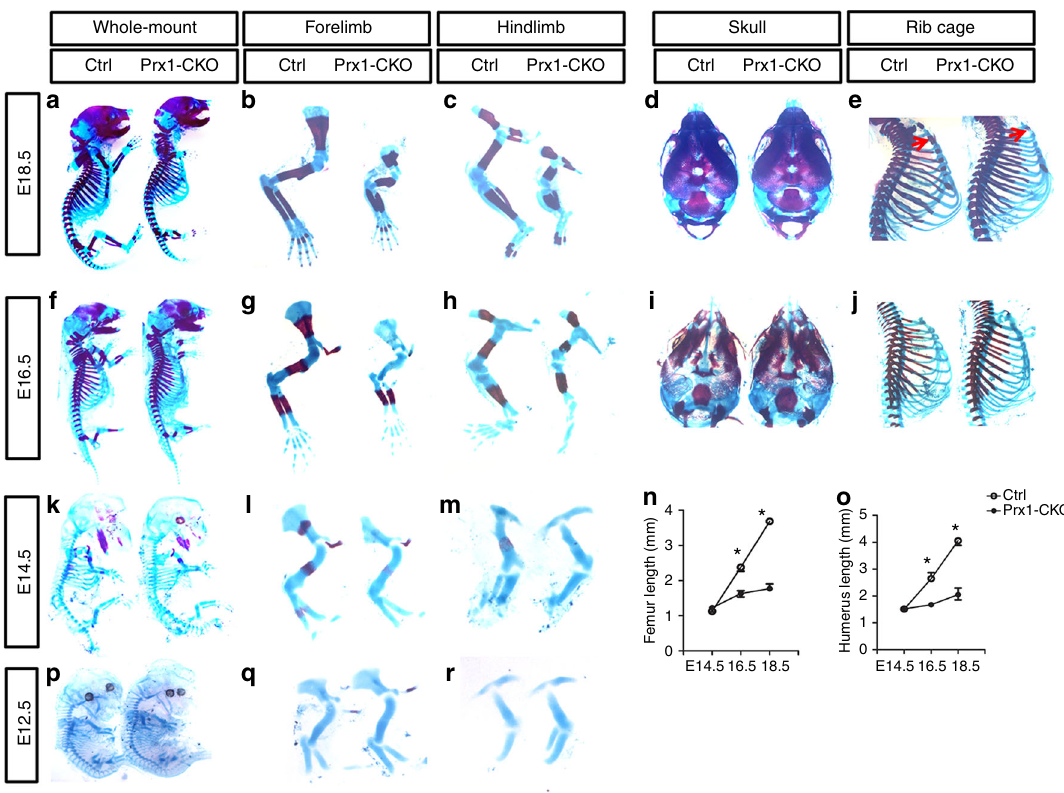
Fig. 2 Deletion of Glut1 with Prx1-Cre leads to severe limb shortening. a – m , p – r Whole-mount skeletal staining of normal (Ctrl) or mutant (Prx1-CKO) littermate embryos at E18.5 ( a – e ), E16.5 ( f – j ), E14.5 ( k – m ), and E12.5 ( p – r ). Red arrows denote hypomineralization of the mutant sternum compared to control at E18.5. n , o Length measurements of femurs ( n ) and humeri ( o ) at indicated embryonic stages. * p < 0.05, n = 3, error bar indicates SD, two-way ANOVA and Bonferroni post-test. Each image is representative of three